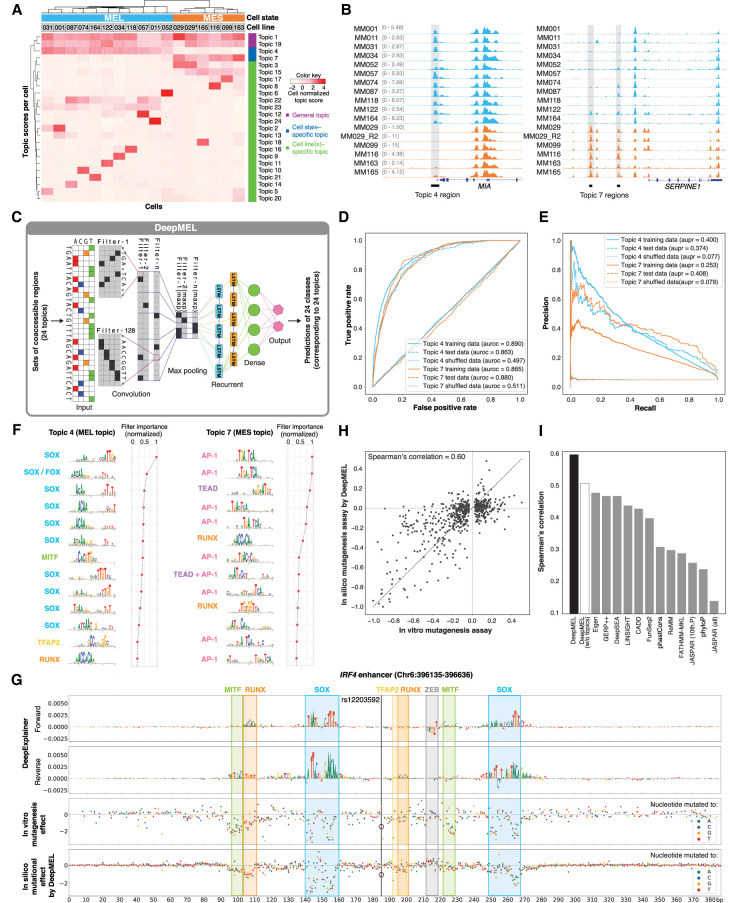
DeepMEL classifies melanoma enhancers and predicts important TF binding motifs. (A) Cell-topic heatmap of cisTopic applied to 339,099 ATAC-seq regions across the 16 human melanoma lines, colored by normalized topic scores. (029*) MM029_R2. (B) Example regions of a MEL-specific (topic 4) region near MIA and MES-specific (topic 7) regions upstream of SERPINE1. (C) Schematic overview of DeepMEL. Twenty-four topics or sets of coaccessible regions were used as input for training of a multiclass multilabel neural network. (D,E) Receiver operating characteristic curve (D) and precision recall curve (E) for DeepMEL on training, test, and shuffled data of topic 4 and topic 7 regions. (F) Top enriched filters learned by DeepMEL to classify regions as MEL (topic 4) or MES (topic 7). Normalized filter importance is shown per filter. (G) Example of a MEL-predicted enhancer near IRF4. (First and second rows) DeepExplainer view of the forward and reverse strand, with the height of the nucleotides indicating the importance for prediction of the MEL enhancer. (Third row) In vitro effect of point mutations on enhancer activity as measured by MPRA (Kircher et al. 2019). Colors represent the nucleotide to which the wild-type nucleotide is mutated. (Fourth row) In silico effect of point mutations as predicted by DeepMEL. (H) Correlation between the in vitro mutational effects on the IRF4 enhancer and the in silico mutagenesis predictions. (I) Performance of variant effect prediction of DeepMEL using topics (black bar, model used in this paper) or using ATAC-seq signal (white bar), and several previously tested models on the IRF4 enhancer case (Kircher et al. 2019).